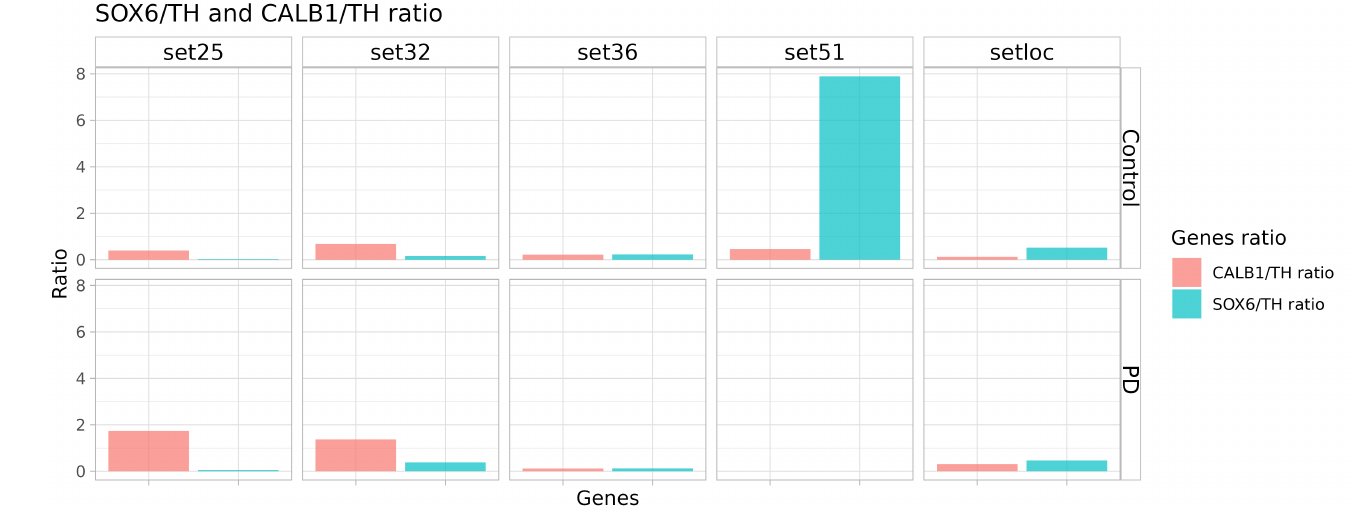
Figure 11. CALB1/TH and SOX6/TH ratio as an indirect assessment of the proportion of resistant and sensitive cells in the DAn cultures in comparison between